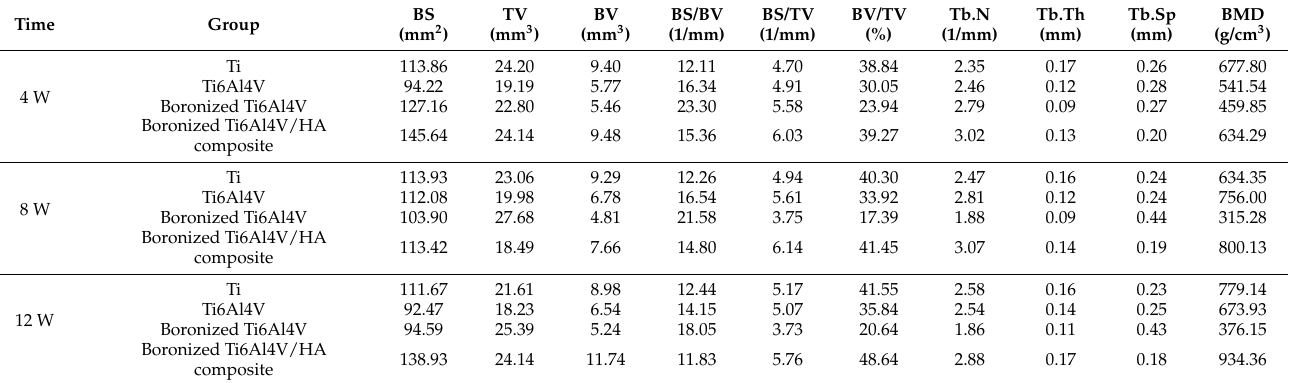
Table 1. Quantitative analysis of new bone formations around implants by micro-CT at the 4th, 8th, and 12th weeks after implantation.